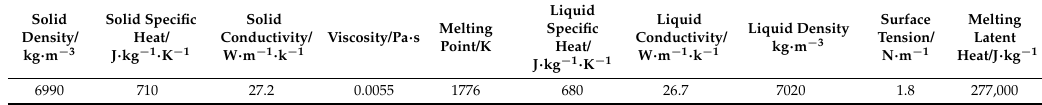
Table 1. The physical parameters used in the simulation.